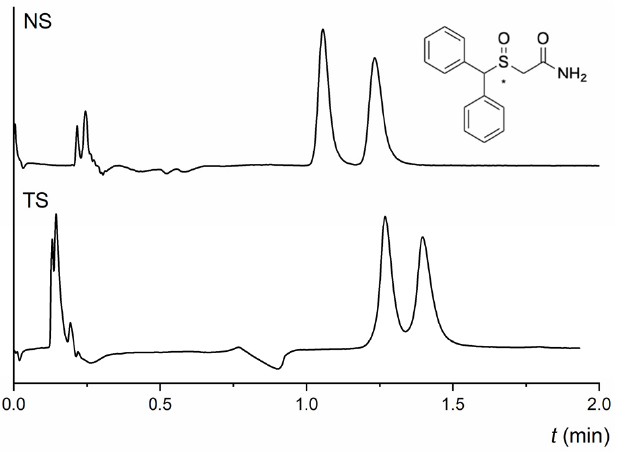
Figure 7. Chromatograms of fast baseline enantioseparation of modafinil on NicoShell (NS) and TeicoShell (TS) columns. MP composition: CO 2 /MeOH/H 2 O (80/20/1.25, v / v / v ); flow rate 1.00 mL min − 1 ; column temperature 25 °C; BP 13.8 MPa, UV detection 220 nm (NS) and CO 2 /EtOH/PrOH/H 2 O/TFA/TEA (85/12/3/0.5/0.1/0.1, v / v / v / v / v / v ); flow rate 2.00 mL min − 1 ; column temperature 25 °C; BP 13.8 MPa, UV detection 220 nm (TS). (*) in the structure indicates a stereogenic center.